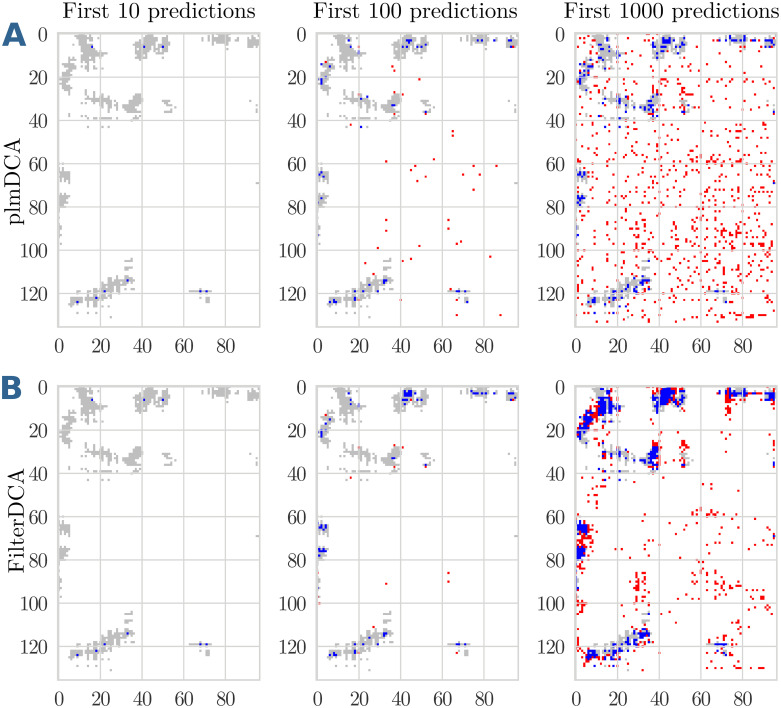
Contact map prediction for the interaction between the domain families PF02773 and PF00438 co-occurring in S-adenosylmethionine synthetases.The upper panels (A) show the predictions of plmDCA, the lower panels (B) those of FilterDCA, for the first 10, 100 or 1000 predicted contacts. In each figure, the native contacts are shown in grey, TP predictions of the two methods in blue, FP predictions in red. This example shows a case where plmDCA detects some signal, which is subsequently cleaned by FilterDCA.